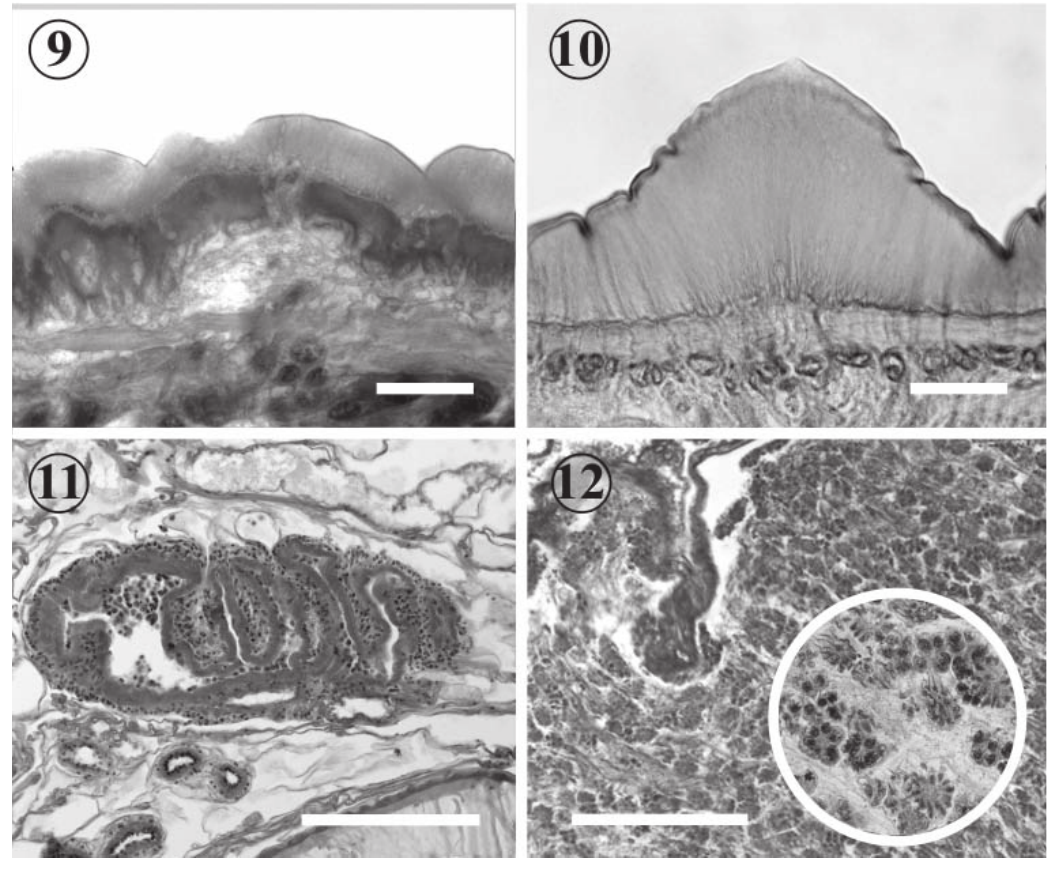
Figs. 9 – 10. Histological section of the tegument from the anterior end of the rumen fluke. Fig. 9 shows the wavy and thin tegumental syncytium of a uniform thickness in the winter fluke. Fig. 10 shows the corresponding area in the summer fluke. The syncytium is thick, forming a conical nonciliated papilla at the anterior end. Scale bar = 20 µm. Figs. 11 – 12. LM micrographs showing the seasonal variation in the testes of a reindeer rumen fluke. Fig. 11 depicts the immature testis of the winter fluke. It possesses deeply folded capsule and dark-stained primordial germ cells. Fig. 12 shows part of the testis of a mature summer fluke. The capsule forms only a few septa. The insert shows the stages of spermatogenesis and mature spermatozoa. Scale bar = 200 µm. Figs. 13 – 14. LM micrographs showing seasonal variation observed in the vitelline cells and follicles of a reindeer rumen fluke. Fig. 13 shows clusters of intensively stained vitellin cells (arrows) in the parenchyma beneath the tegumental cells of the winter fluke. Fig. 14 shows a part of the mature vitellin follicle of the summer fluke with immature and mature cells containing shell globules. Scale bar = 200 µm. Figs. 15 – 16. LM micrographs showing seasonal variation observed in the ovaries of reindeer rumen flukes. The immature ovary (arrow), Mehlis’ gland (mg), and excretory vesicle (ev) of the winter fluke are seen in the same micrograph (Fig. 15). Fig. 16 shows the corresponding area during summer. Only part of the ovary with mature oocytes is depicted. Scale bar 200 = µm. Figs. 17 – 18. LM micrographs showing seasonal variation observed in Mehlis’ gland of the reindeer rumen fluke. Fig. 17 shows the small Mehlis’ gland of the winter fluke (arrow) with the vitellin duct (vd) and sections of the uterus (u). Fig. 18 shows an active Mehlis’ gland forming an egg in the summer fluke. Eggs (e) can be observed within the lumen of Mehlis’ gland and adjacent to the gland. Scale bar = 200 µm. Figs. 19 – 20. LM micrographs showing seasonal variation observed in the uterus of the reindeer rumen fluke. Fig. 19 shows the winding immature uterus (arrows) of the winter fluke. Fig. 20 depicts the uterus during the summer. Scale bar = 200